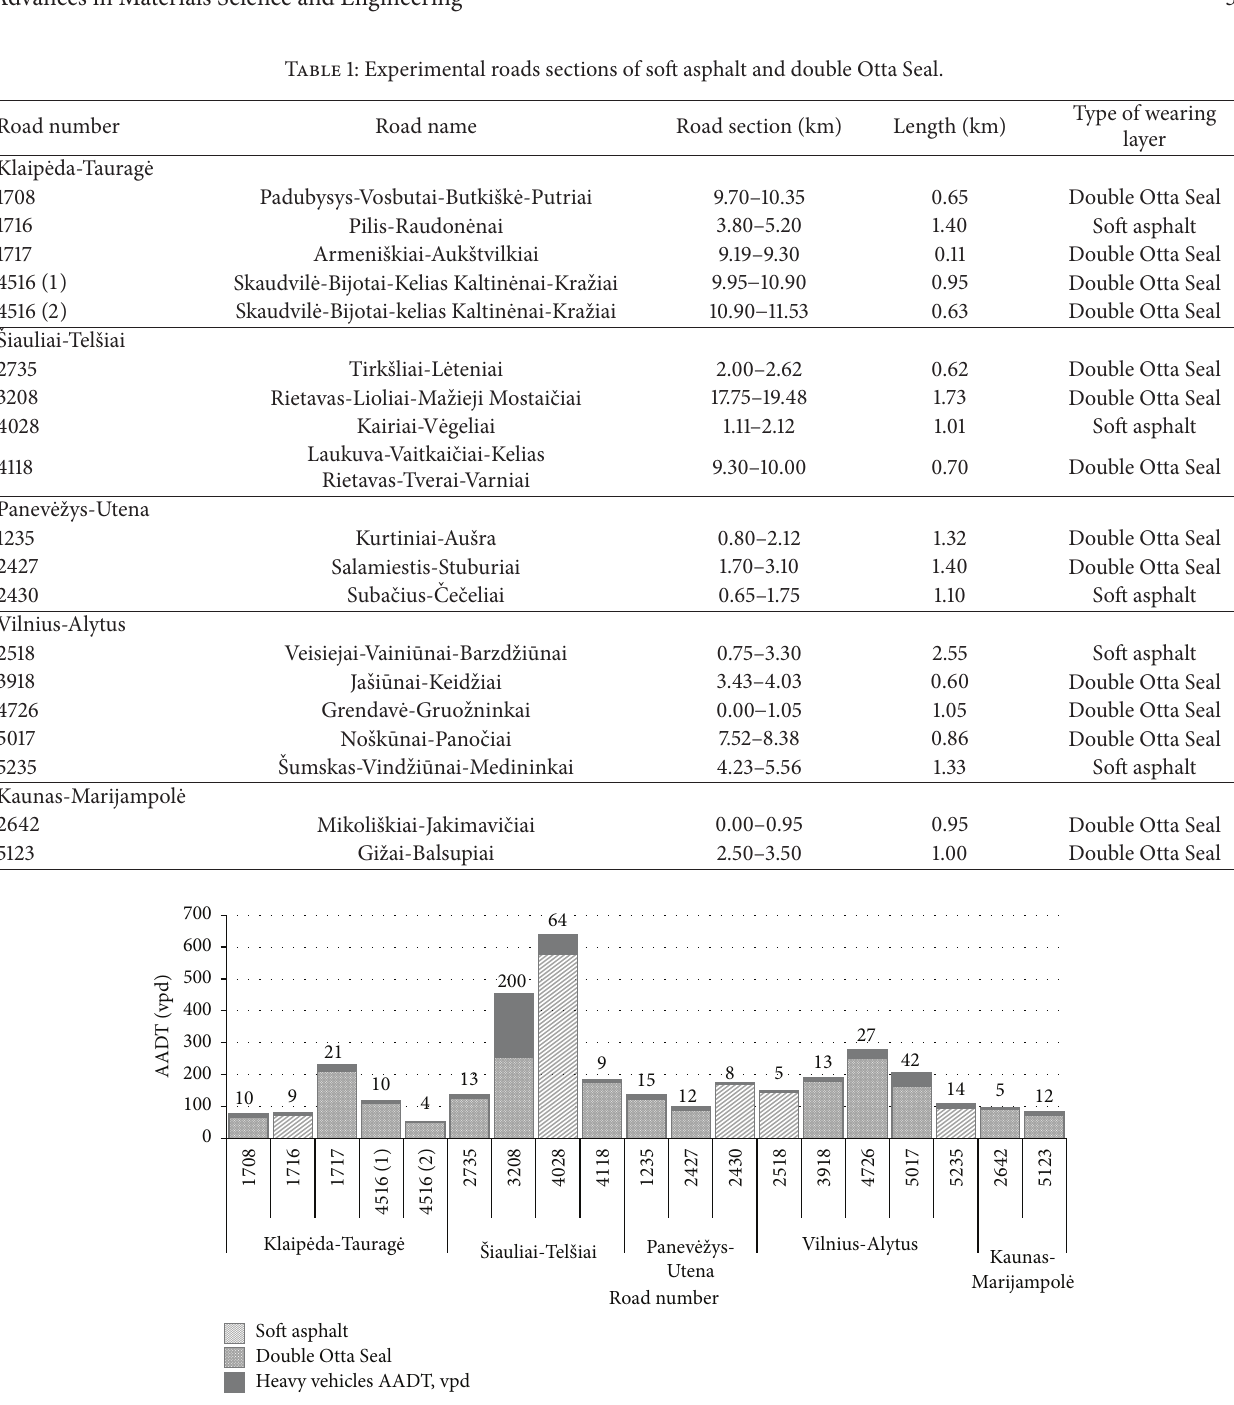
Figure 1: AADT and heavy vehicles AADT at experimental roads